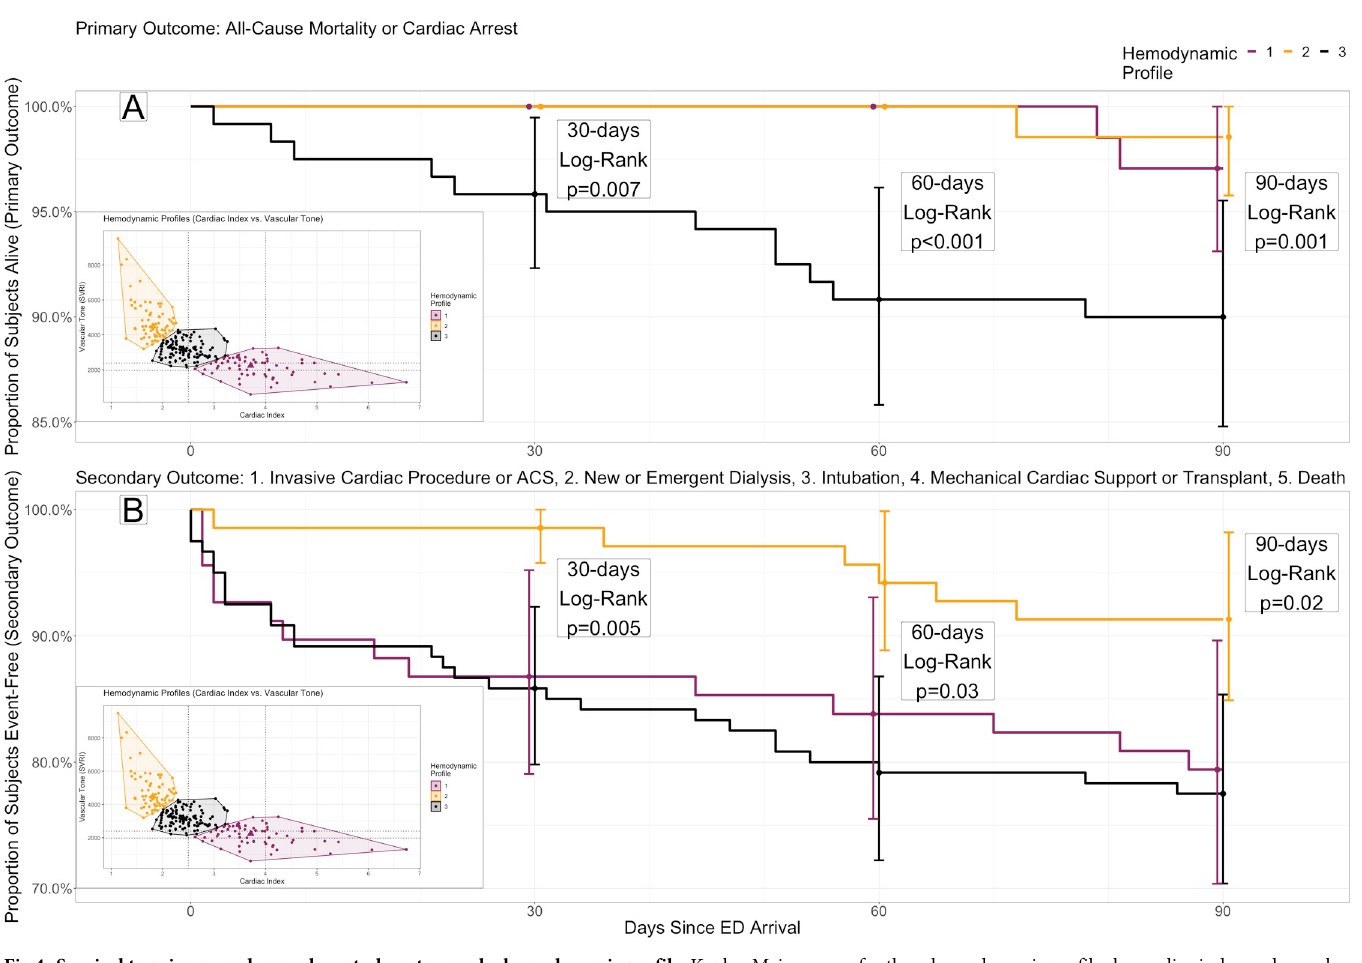
Fig 4. Survival to primary and secondary study outcomes by hemodynamic profile. Kaplan Meier curves for three hemodynamic profiles by cardiac index and vascular tone (see inset) in the validation cohort, through 90-day follow-up. (A) Primary outcome: All-cause mortality or cardiac arrest. Profile 3 (black) has significantly worse survival compared to profiles 1 or 2 (purple and gold, respectively) through each of 30, 60 and 90 days. (B) Secondary outcome: A composite of invasive cardiac procedure, new or emergent dialysis, intubation, mechanical cardiac support or transplant, and death or cardiac arrest. Profile 2 has significantly better event-free survival compared to profiles 1 or 3 through each of 30, 60 and 90